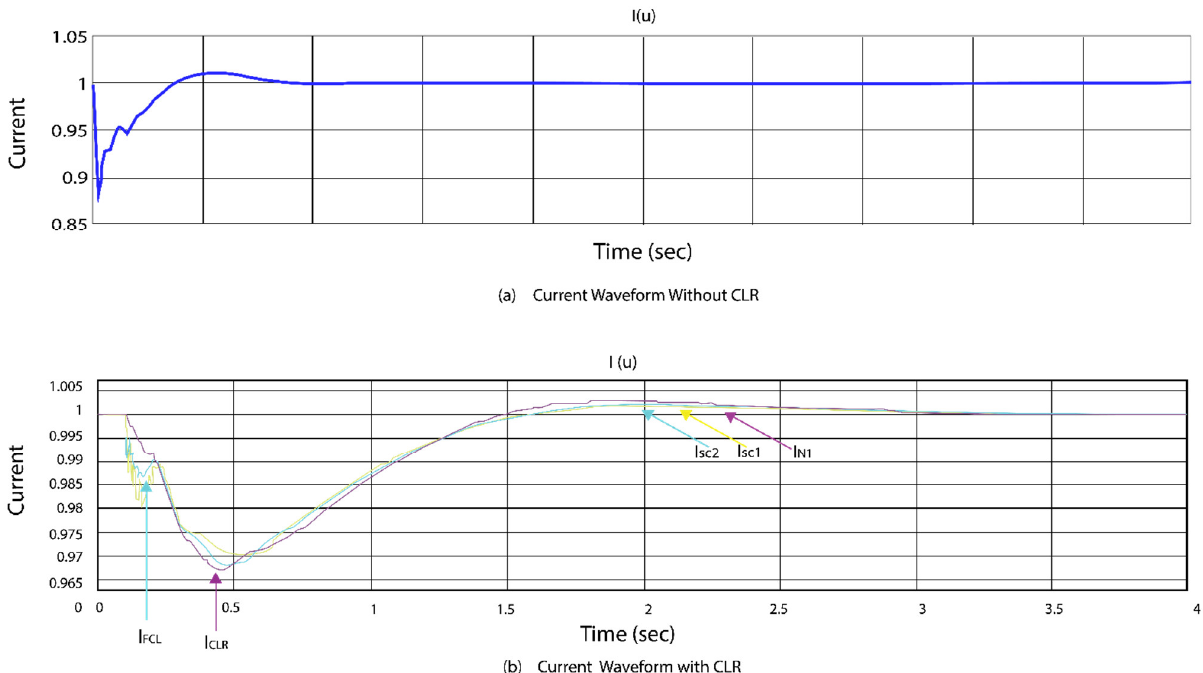
Figure 8. Current (ampere) waveforms due to the CLR’s resistance (pu).